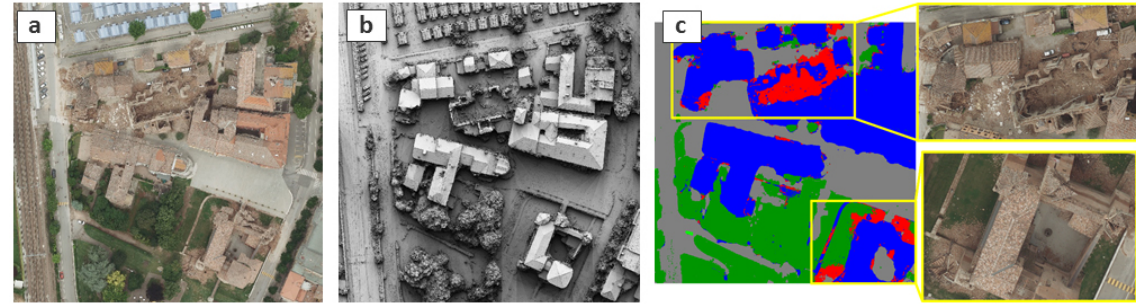
Figure 6. True orthophoto, digital surface model and damage map of an urban area using airborne nadir images (source: Nex et al.,